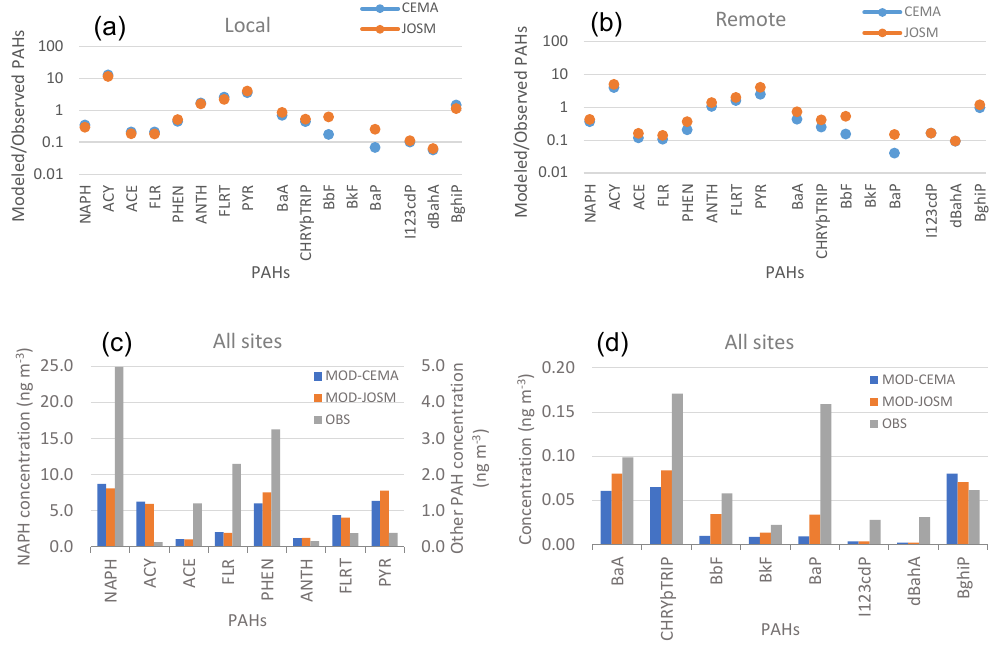
Figure 3. Ratios of CEMA and JOSM modelled concentrations to observed concentrations of speciated PAHs at local (a) and remote (b) sites. Comparison of average CEMA and JOSM modelled concentrations and observed concentrations at all sites (c, d) . Note the different y -axis scales for the concentrations in (c) and (d)